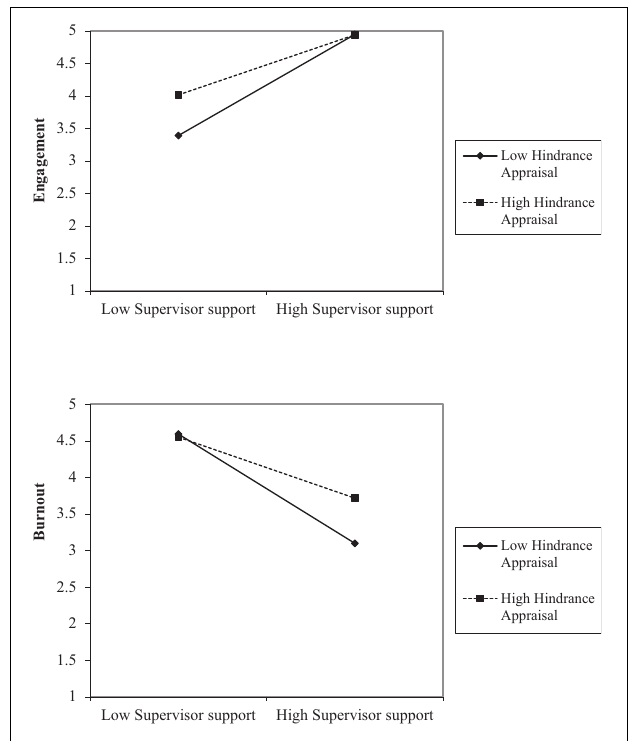
FIGURE 3 | The interactions between supervisor support and hindrance appraisal on engagement (top) and burnout (bottom) in Study 1.